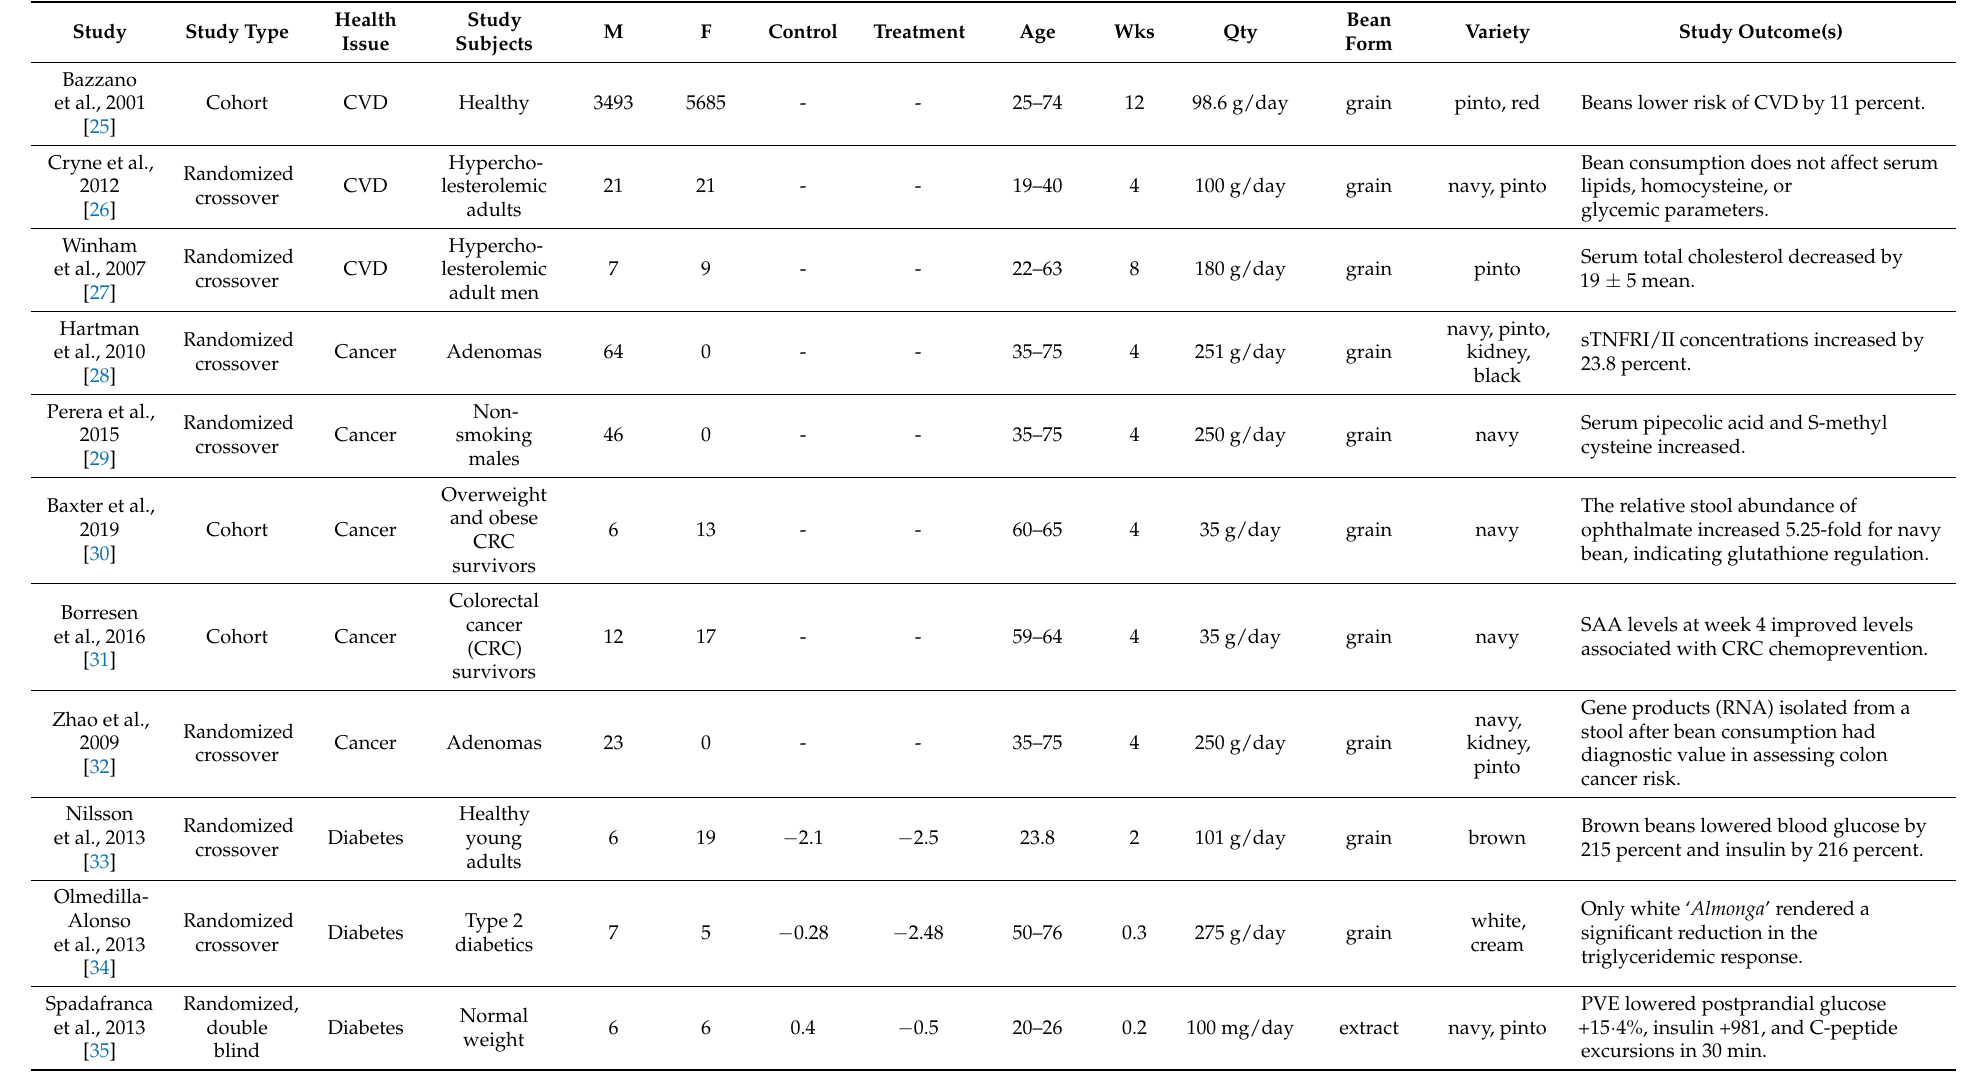
Table 1. Selected studies that characterize the association between common bean consumption and